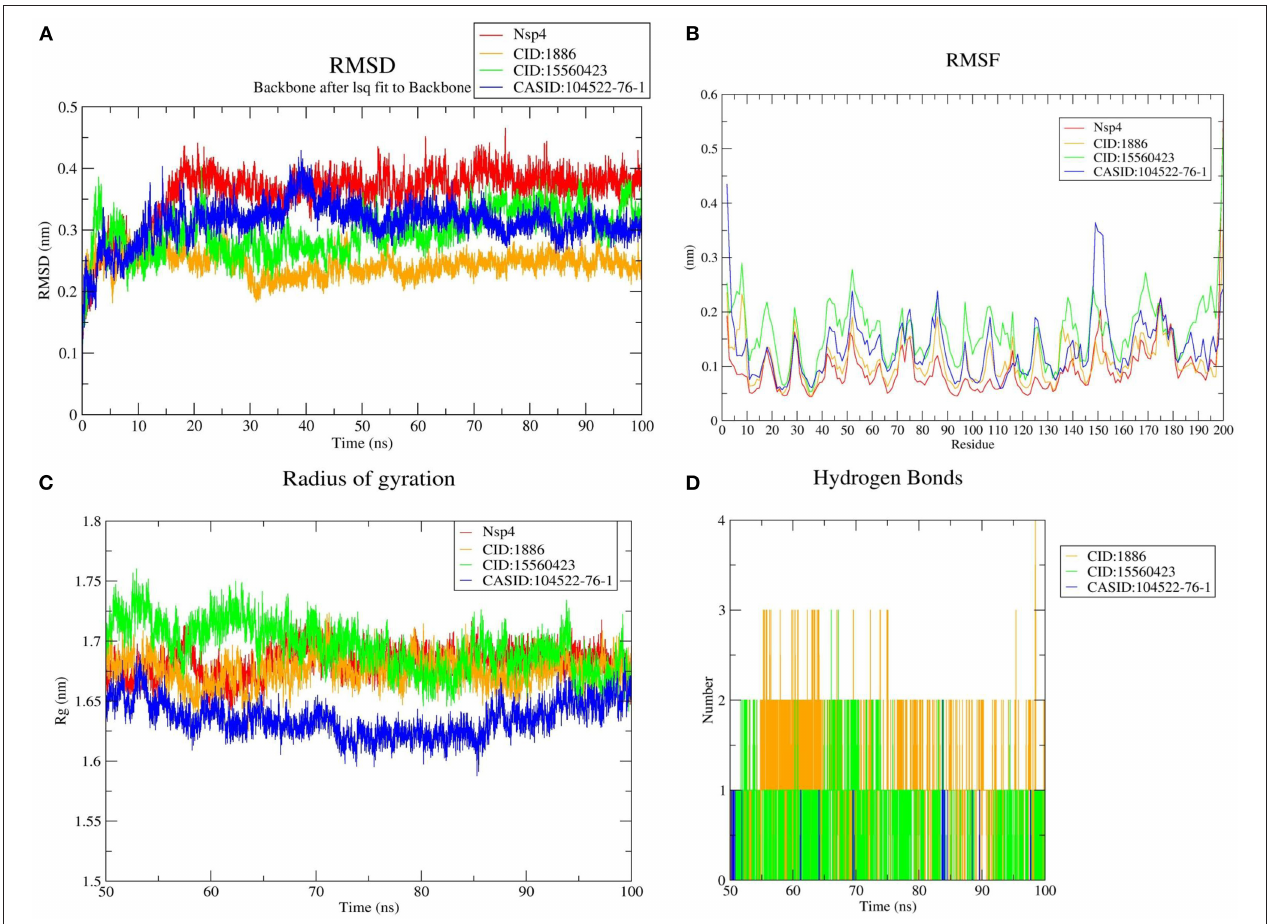
FIGURE 4 | MD simulation results, (A) RMSD plot of Nsp4 and the Nsp4-phytochemical complexes, (B) RMSF, and (C) Rg plots of Nsp4 and the Nsp4-phytochemical complexes over the final 50 ns of the MD simulations. Red, orange, green, and blue colors represent Nsp4, Nsp4-CID:1886, Nsp4-CID:15560423, and Nsp4-CASID:104522-76-1, respectively. (D) A plot showing the number of hydrogen bonds formed over the final 50 ns trajectory for each respective complex. Orange, green, and blue colors represent Nsp4-CID:1886, Nsp4-CID:15560423, and Nsp4-CASID:104522-76-1,